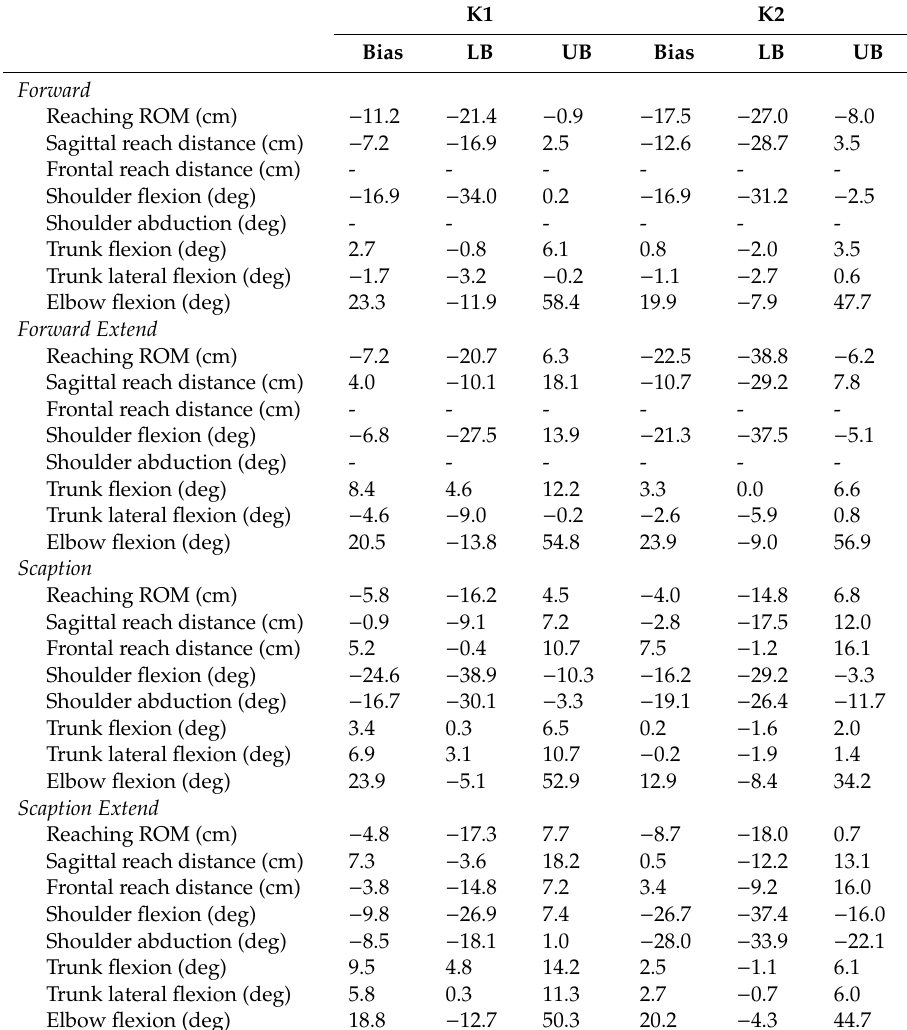
Table A2. Validity measured by mean bias (Bias) and Bland-Altman limits of agreement, lower bound (LB) and upper bound (UB), for K1 and K2 in comparison to VMC on